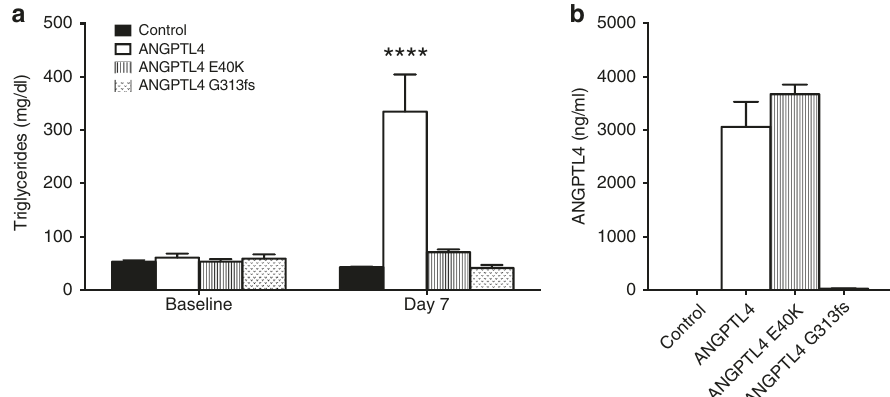
Fig. 3 K40 and G313fs abolish ANGPTL4 effect on triglycerides. a Plasma triglycerides levels (4 h fasted) in C57Bl/6 mice before (Baseline) and 7 days after (Day 7) hydrodynamic delivery via tail vein injection of cDNA encoding human E40, K40, and Gly313fs ANGPTL4 variants. Control animals were injected with empty vector. b ANGPTL4 plasma levels were measured in the animals described in ( a ). All groups had fi ve animals. Values are mean ± SEM. Statistics performed by two-way ANOVA with Bonferroni correction, **** p < 0.0001 vs control